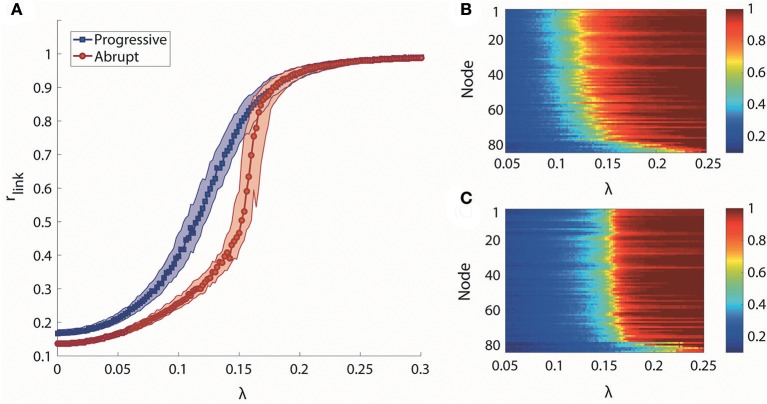
Global and local synchronization for progressive and abrupt transitions. (A) Median global order parameter of progressive (blue) and abrupt (red) transitions for 100 frequency configurations. Colored area indicates the 25–75% values of rlink of 100 configurations. Local order parameter ri of (B) progressive and (C) abrupt transition. The nodes are aligned with descending order of degree from top to bottom. Color indicates the value of ri.